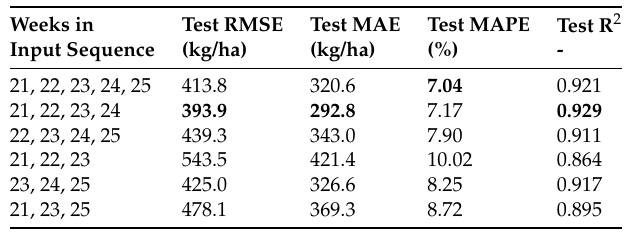
Table 7. Retraining results of the best performing 3D-CNN configuration with various input sequence configurations from the test set. The input data was constructed from the first five imagings (weeks 21 to 25). The composition of weekly data was varied and variations evaluated by fitting the best performing 3D-CNN configuration to each variation. Best performance values are in bold text.